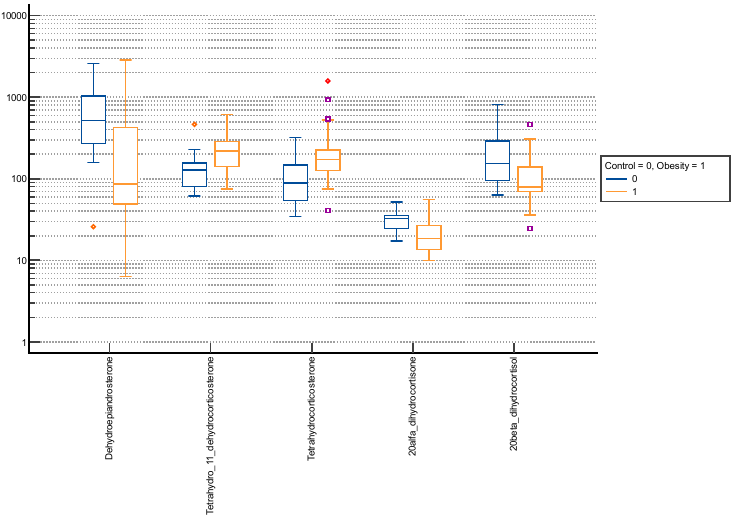
Figure 3. Comparative box plots of steroid metabolites with statistically significant differences ( p - value < 0.05) between the normal weight and obesity boys in the advanced puberty group. A loga- rithmic scale was used. Exact results are available in Supplementary Table S2. Purple square – out- liers; red circle – extreme values.